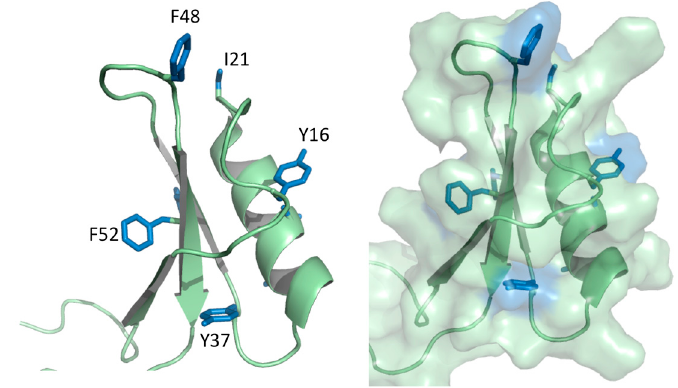
Figure 3. Hydrophobic residues arising from the anti ‐ parallel β‐ sheet and α‐ helix of sugar cane defensin (SD)5. Close ‐ up views of the SD5 structure (cartoon and surface representations) showing side chains of the hydrophobic residues. Note that all hydrophobic residues are surface exposed. The aromatic residues located at the secondary structure elements are indicated.